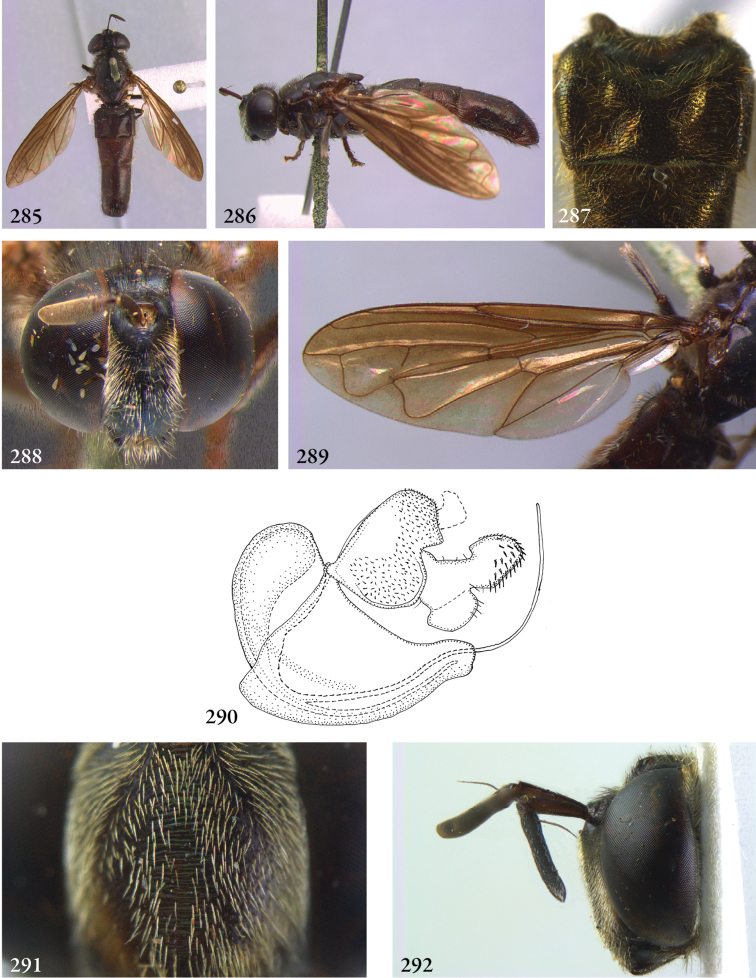
285–289
Parocyptamus sonamii male (syntype, except 290 Thailand, coll. RMNH): 285 habitus dorsal 286 habitus lateral 287 tergite 2 dorsal 288 head frontal 289 wing 290
Parocyptamus stenogaster male (holotype), genitalia lateral 291–292
Peradon bidens male (Surinam, coll. RMNH): 291 face frontal 292 head lateral.